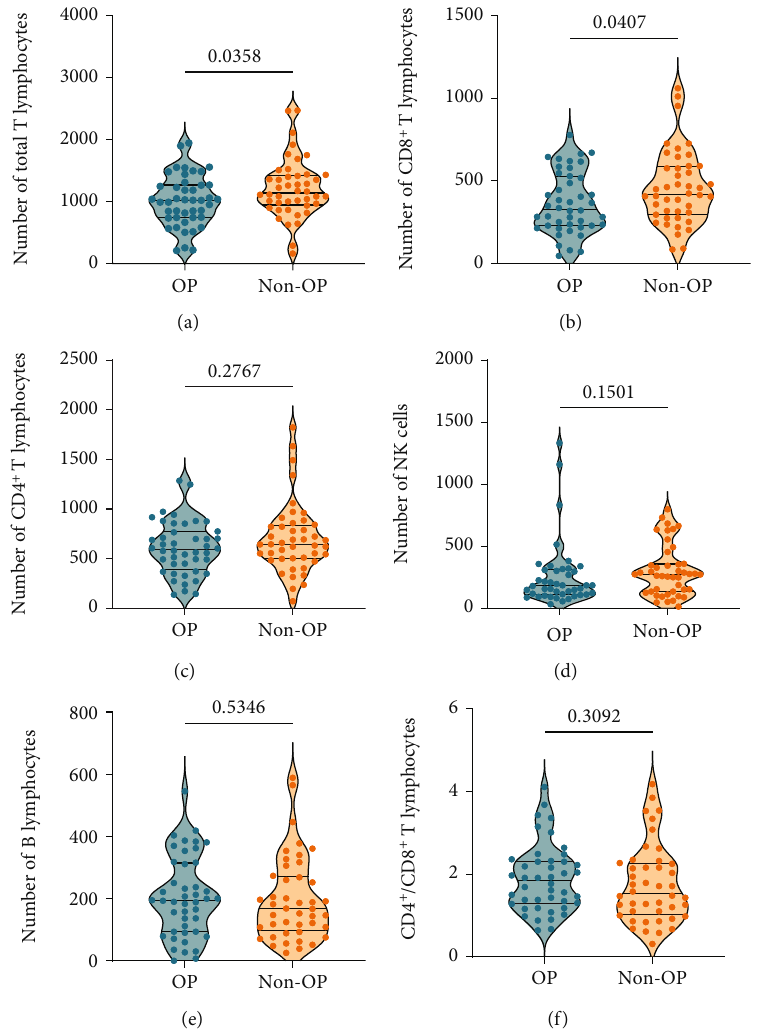
Figure 2: Comparison of the absolute counts of lymphocyte subsets between the OP and non-OP groups. The absolute counts of total T lymphocytes (a), CD8 + T lymphocytes (b), CD4 + T lymphocytes (c), NK cells (d), B cells (e), and CD4 + /CD8 + T lymphocytes ratio (f) between the OP and non-OP groups were analyzed. Continuous variables in the normal distribution of the two groups were expressed as mean ± standard deviation ( mean ± SD ) and analyzed with the unpaired t -test. Continuous variables in the abnormal distribution were expressed as quartiles (50% (25%-75%)) and analyzed by the Mann-Whitney U test. P value < 0.05 was considered a signi fi cant di ff ( P = 0 : 0407 , Figure 2(b)) were signi fi cantly lower in the OP group than in the non-OP group. In addition, there were no signi fi cant di ff erences in the absolute counts of CD4 + T lymphocytes ( P = 0 : 2767 , Figure 2(c)), NK cells ( P = 0 : 1501 , Figure 2(d)), B cells ( P = 0 : 5346 , Figure 2(e)), and the (Figure 3(a), P = 0 : 0030 , R 2 = 0 : 1115 , Y = 0 : 003151 ∗ X − CD4 + /CD8 + T lymphocyte ratio ( P = 0 : 3092 , Figure 2(f)) 3 : 002 ) and height (Figure 3(b), P = 0 : 0030 , R 2 = 0 : 1113 , Y between the OP and non-OP groups. = 7 : 878 ∗ X − 14 : 64 ). Similarly, the BMD of the total lumbar area increased with age (Figure 3(c), P = 0 : 0028 , R 2 = 0 : 1038 , Y = 0 : 078952 × X − 7 : 226 ) and height (Figure 3(d), P = 0 : 0008 , R 2 = 0 : 1284 , Y = 9 : 849 ∗ X − 17 : 28 ). There was no signi fi cant linear relationship between BMD values of total lumbar, left femoral neck, left hip, and right hip and lym- phocyte subsets, including total T lymphocytes, CD4 + T lymphocytes, CD8 + T lymphocytes, NK cells, B cells, and the CD4 + /CD8 + T lymphocyte ratio. Similarly, no signi fi cant